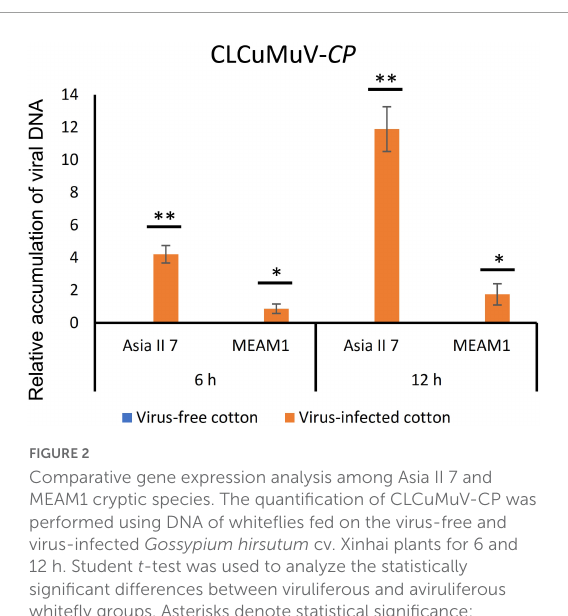
FIGURE2 Comparative gene expression analysis among Asia II 7 and MEAM1 cryptic species. The quantification of CLCuMuV-CP was performed using DNA of whiteflies fed on the virus-free and virus-infected Gossypium hirsutum cv. Xinhai plants for 6 and 12 h. Student t -test was used to analyze the statistically significant differences between viruliferous and aviruliferous whitefly groups. Asterisks denote statistical significance: ∗ P < 0.05; ∗∗ P <